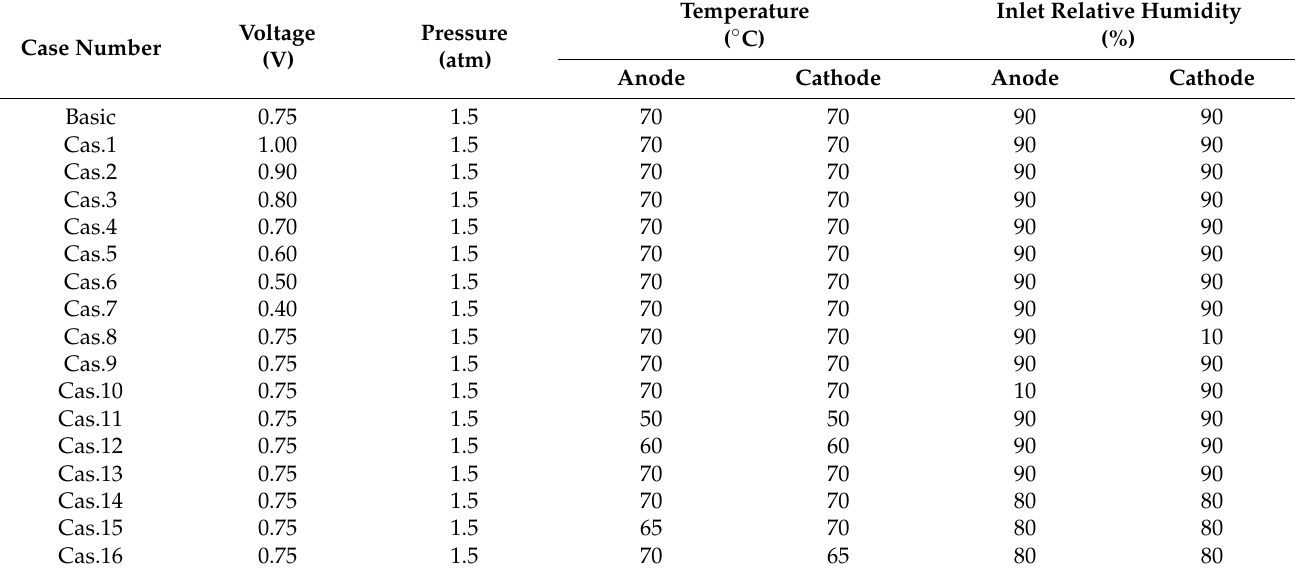
Table 3. Simulation conditions of the